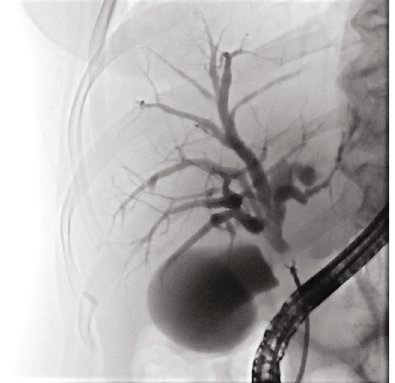
Figure 4: Endoscopic retrograde biopsy of biliary